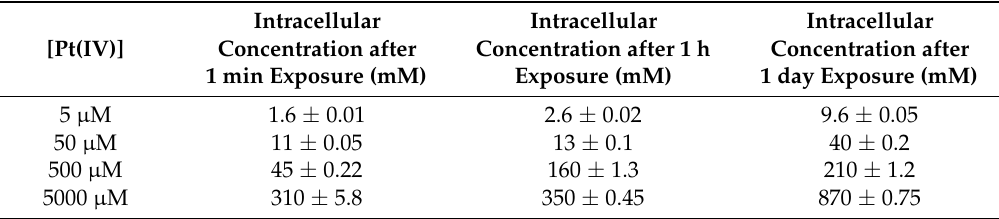
Table 4. Immobilisation study where C. metallidurans was reacted with aqueous Pt(IV).